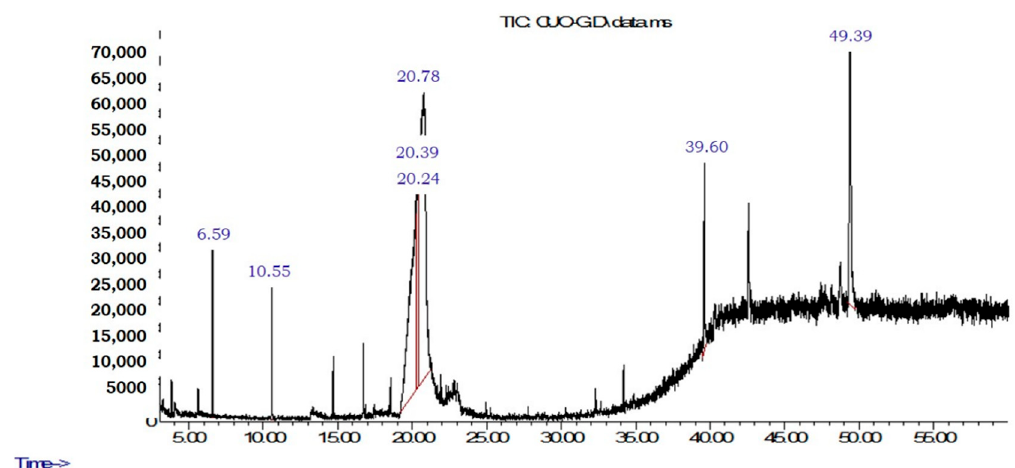
Figure A2. Dipteryx punctata leaves extract chromatogram.